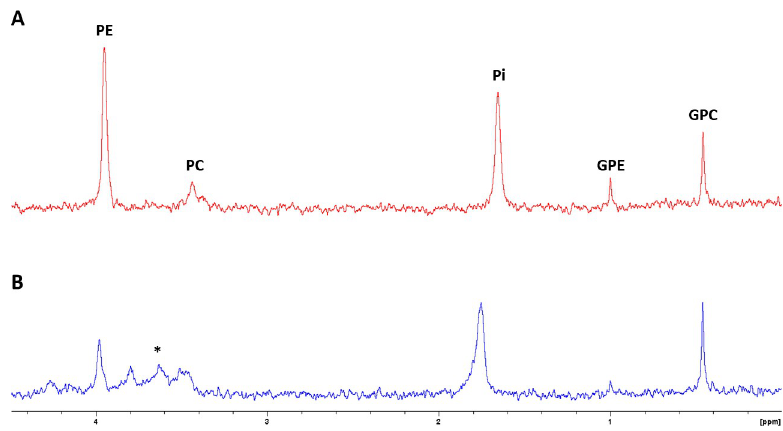
Fig 5. 1 H-decoupled 31 P spectra. Representative examples from an AGA subject corresponding to the ACE group: brain ( A ) and heart ( B ) samples. Spectra referenced to glycerophosphoethanolamine (GPE, 1 ppm). Abbreviations: PE, phosphoethanolamine; PC, phosphocholine; GPC, glycerophosphocholine; Pi, inorganic phosphate. � region with additional peak contributions from 2,3-diphosphoglycerate, in the heart. https://doi.org/10.1371/journal.pone.0208784.g005 (GPC and GPE) in FGR samples (+50% than in AGA), comparable to the CTR group profile; a similar tendency was observed in the GLC group (Fig 6).